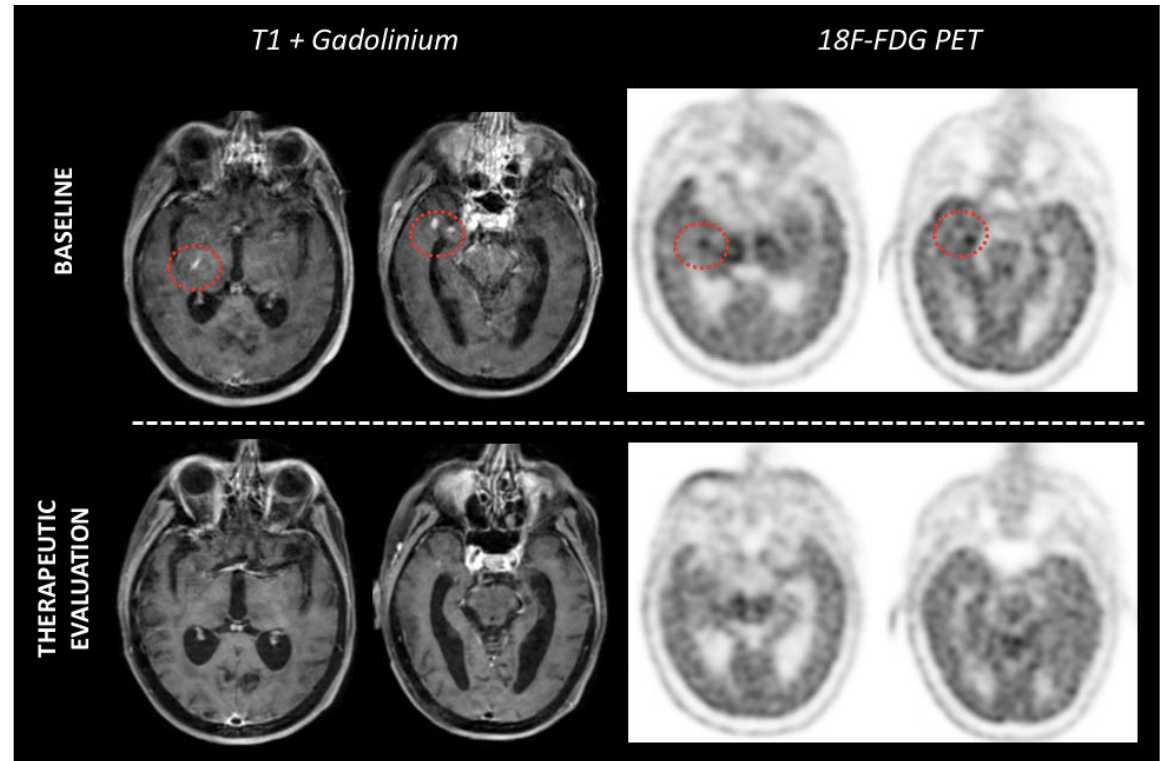
Figure 4. Example case of PET-MRI images of a lymphotamosis cerebri before and after Methotrexate therapy. Baseline images ( top line ) showed small nodular enhanced lesions anterior to the temporal horn of the right ventricle and a linear contrast-enhanced lesion at the posterior arm of the right internal capsule. 18 F-FDG PET images revealed strong uptake consistent with these lesions. After three cycles of methotrexate treatment ( bottom line ), MRI images showed a partial response, while 18 F-FDG PET images had already normalized.